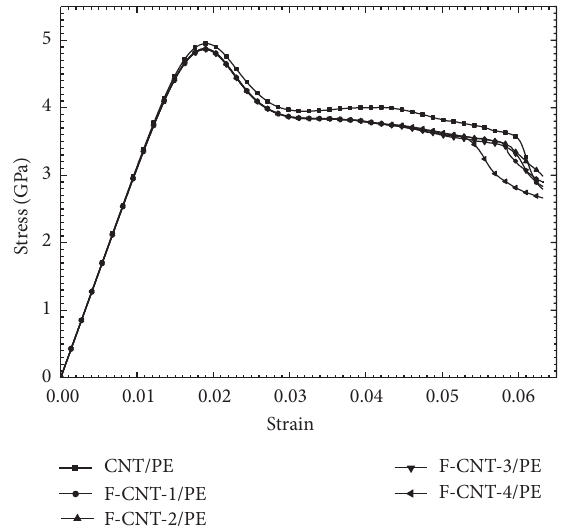
Figure 15: Variation of compression stress versus strain of CNT/PE composites with different functionalization